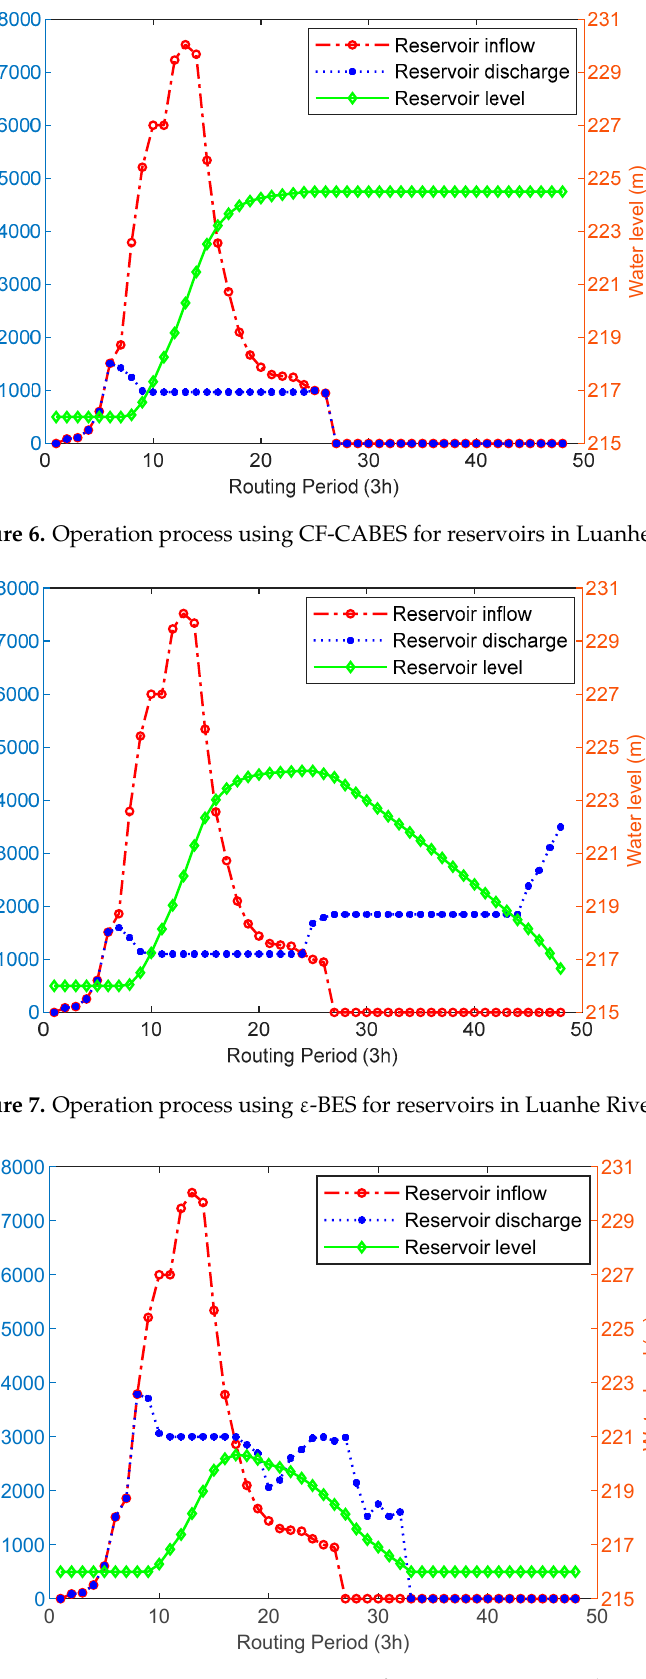
Figure 9. Operation process of Panjiakou Reservoir using ε -PSO. 0